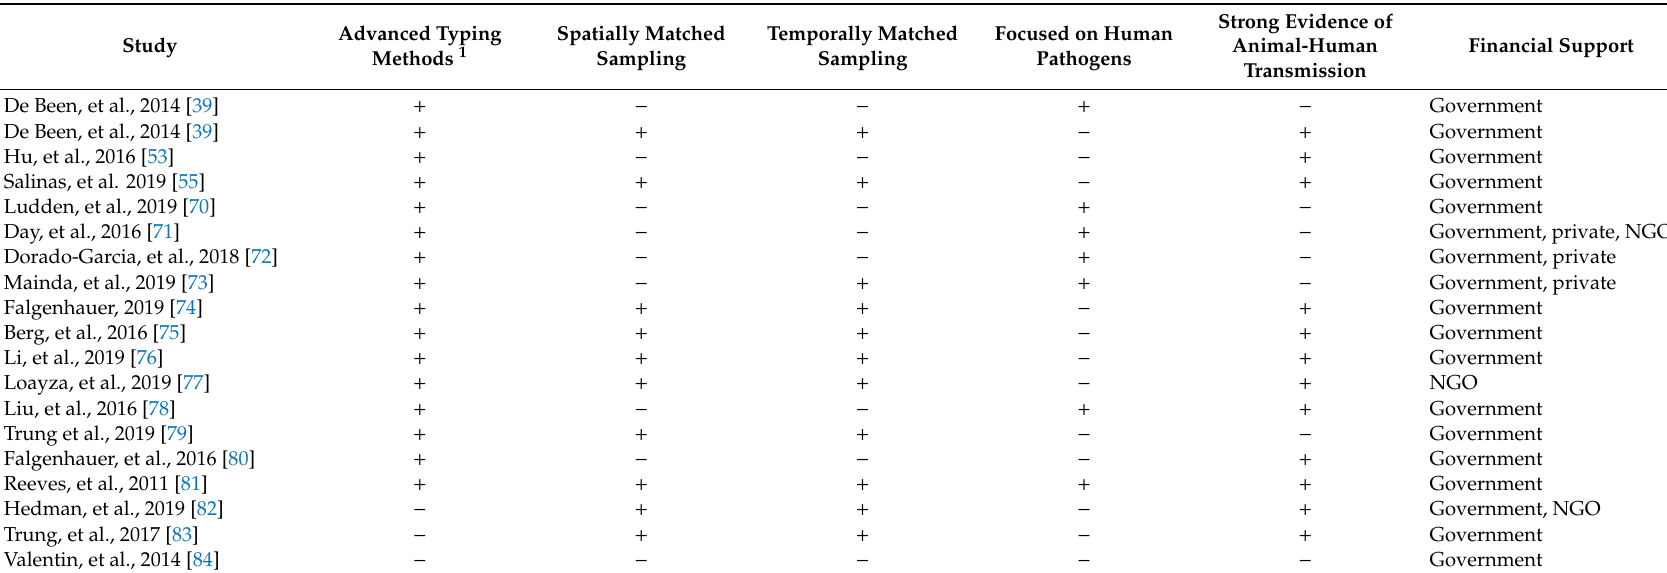
Table 1. Description of studies that applied next-generation sequencing to study interspecies transfer of E. coli or antimicrobial resistance (AMR) genetic